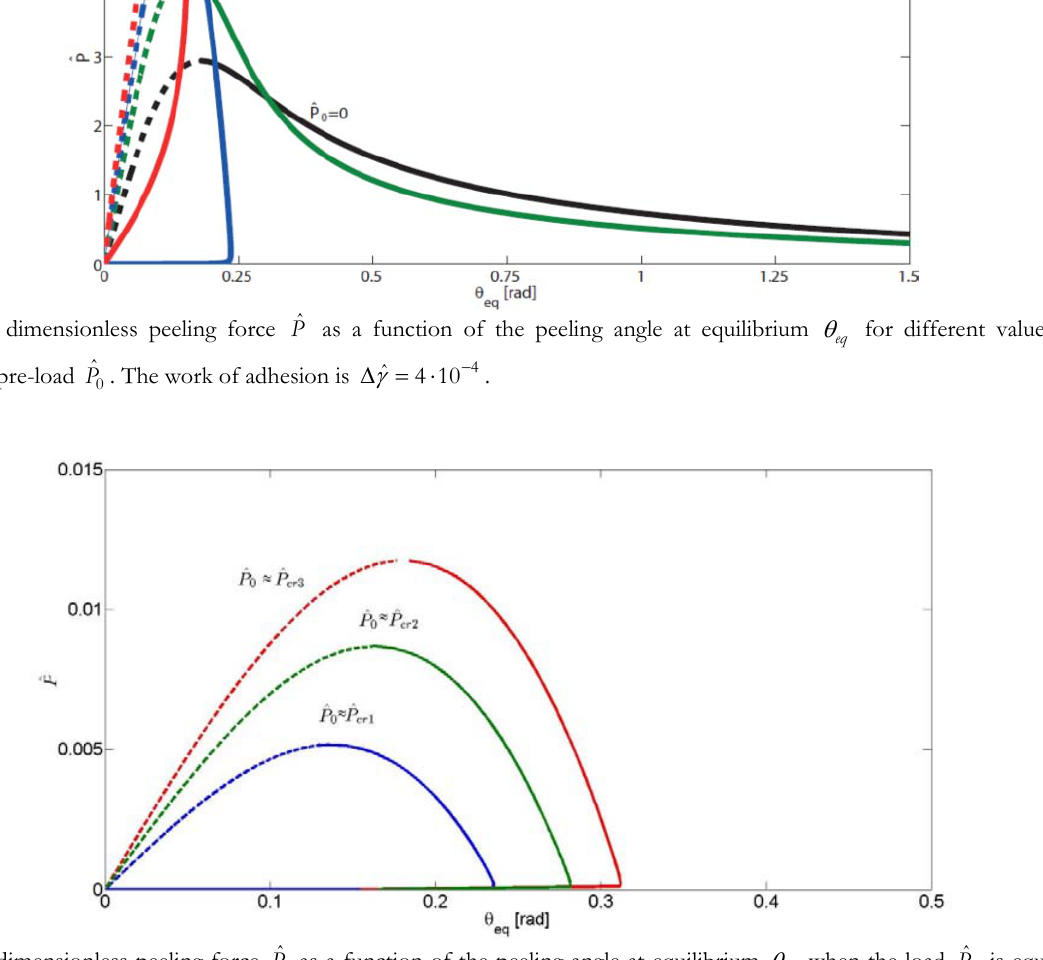
Figure 4: The dimensionless peeling force ˆ P as a function of the peeling angle at equilibrium critical